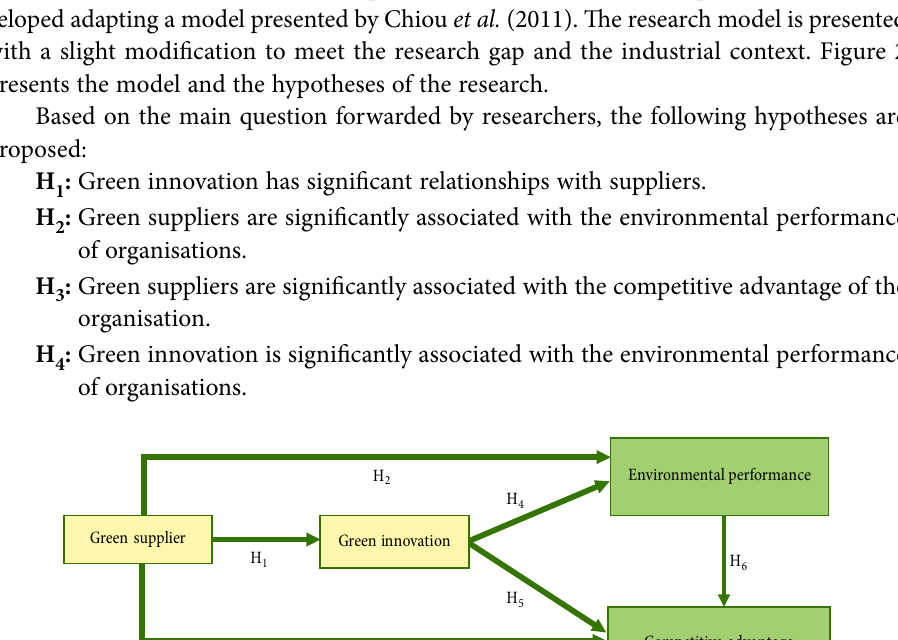
H Fig. 2. Developed conceptual model (adapted from Chiou et al. 2011)